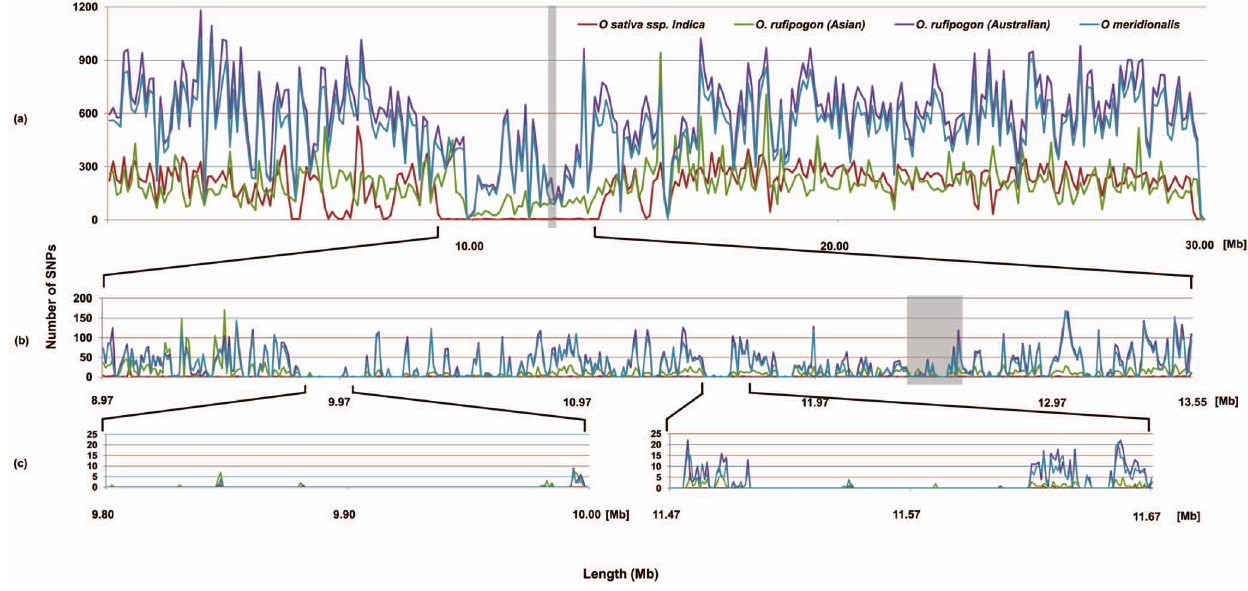
Figure 1. SNP distribution across Chromosome 5. Numbers on vertical axis are SNP/kb. Numbers on vertical horizontal axis are Mb from origin. Vertical grey bar represents the centromere.